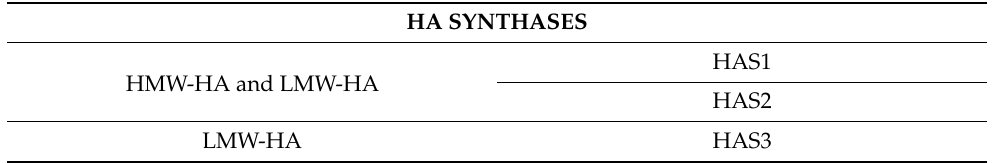
Table 2. HA synthesis enzymes; HMW-HA, high molecular weight HA; MMW-HA, medium molec- ular weight HA; LMW-HA, low molecular weight HA; HAS, HA synthases.